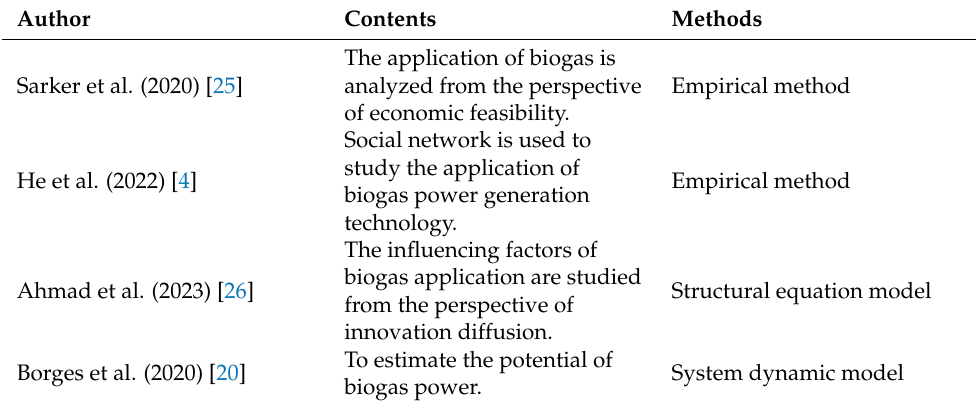
Table 1. The relevant literature can be summarized as